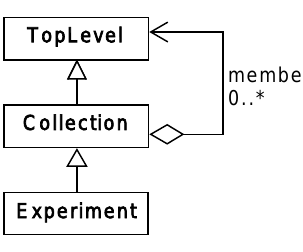
Figure 20: Diagram of the Collection class and its associated properties.